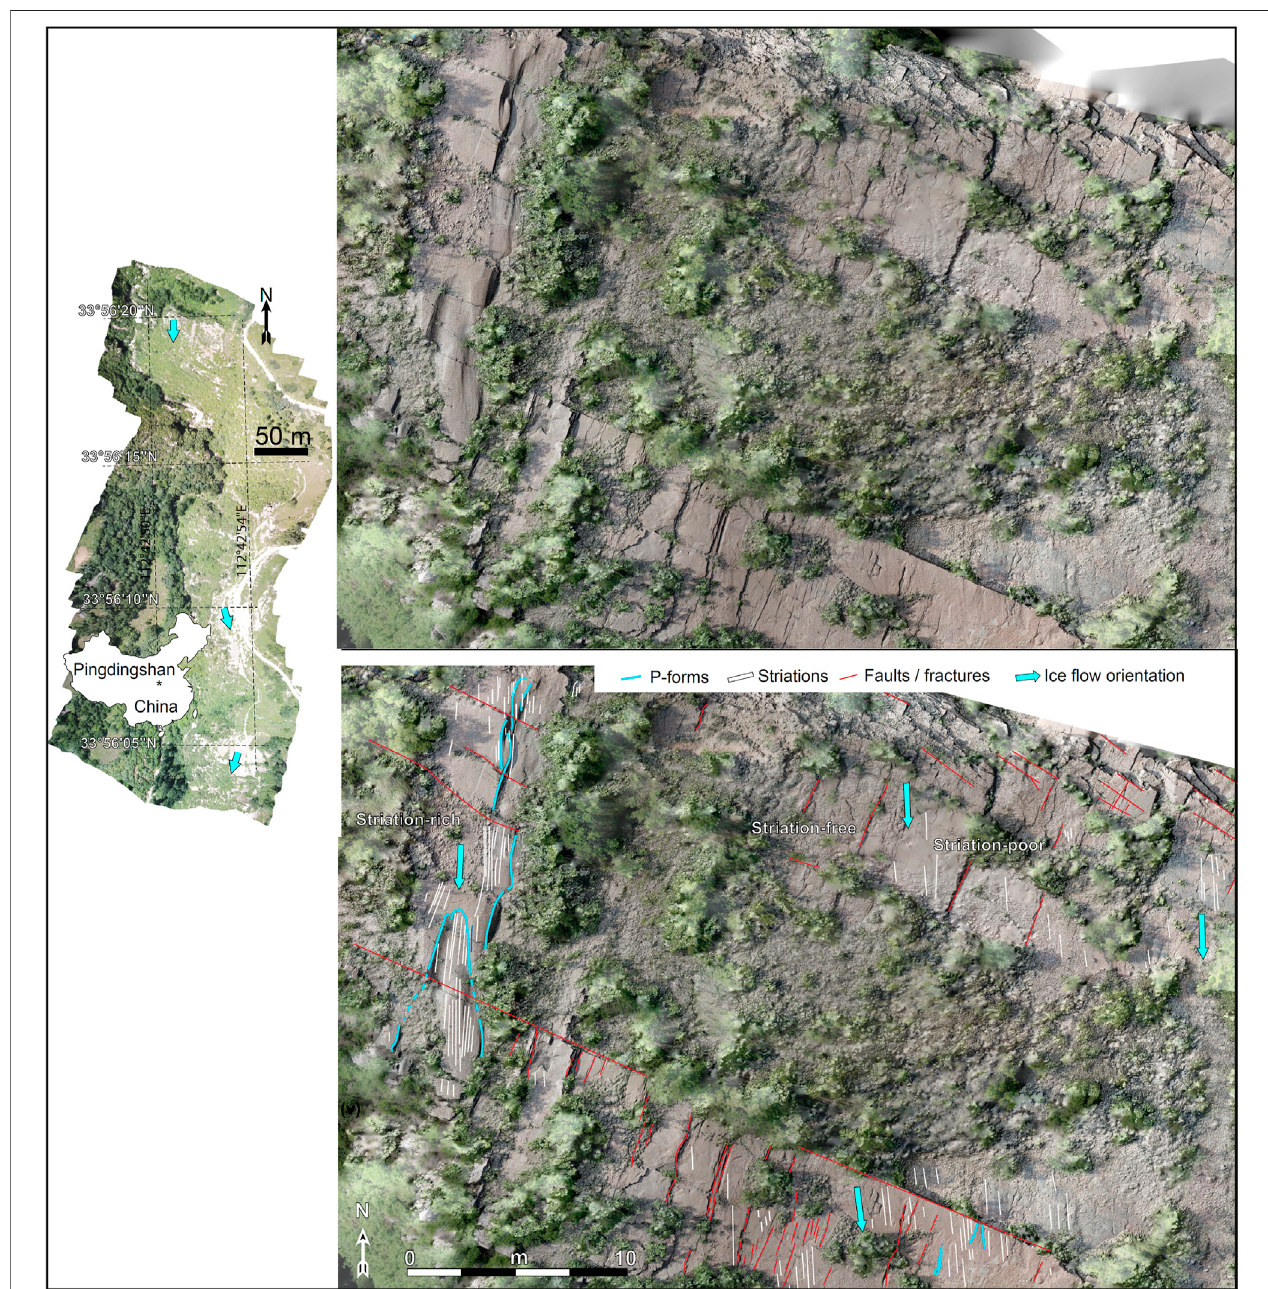
FIGURE 4 | The Pingdingshan striated pavement of Ediacaran age, central China, from Le Heron et al. (2019a). The image derives from data collected by a DJI Mavic Pro UAV in June 2018 as follows. A semi-transparent orthophoto has been draped over a digital elevation model to that small scale topographic differences are emphasised, thereby assisting geomorphic mapping. The abundance of p-forms on this surface highlights the role of subglacial meltwater is sculpting m-scale topography into lithi fi ed sandstone basement.